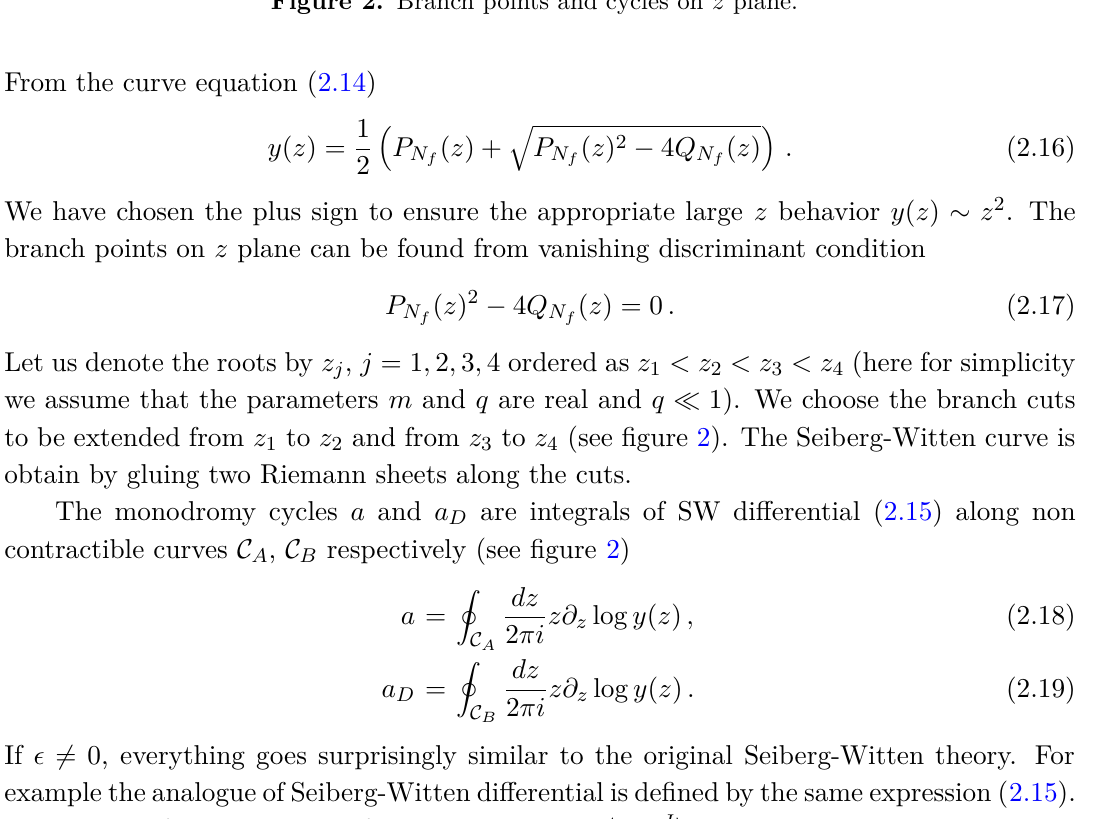
Figure 2. Branch points and cycles on z